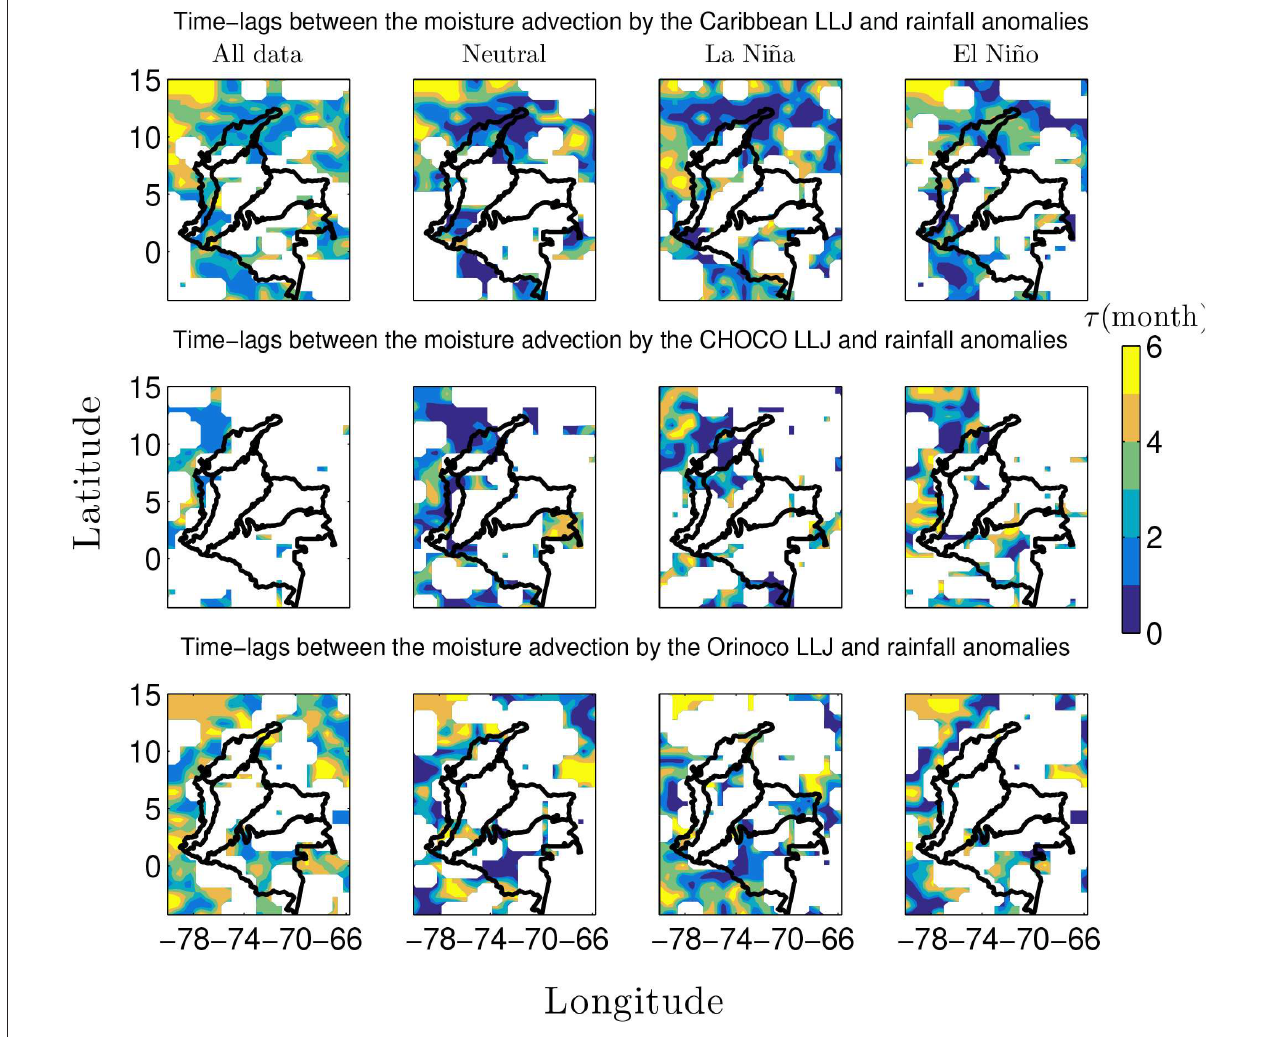
FIGURE 12 | Time-lags between the moisture advection by the low level jets and rainfall anomalies throughout Colombia. (Top row) Caribbean LLJ. (Middle row) CHOCO LLJ. (Bottom row) Orinoco LLJ. Dataset No. 1, period 1975–2006. White indicates zones where GS is not significant at